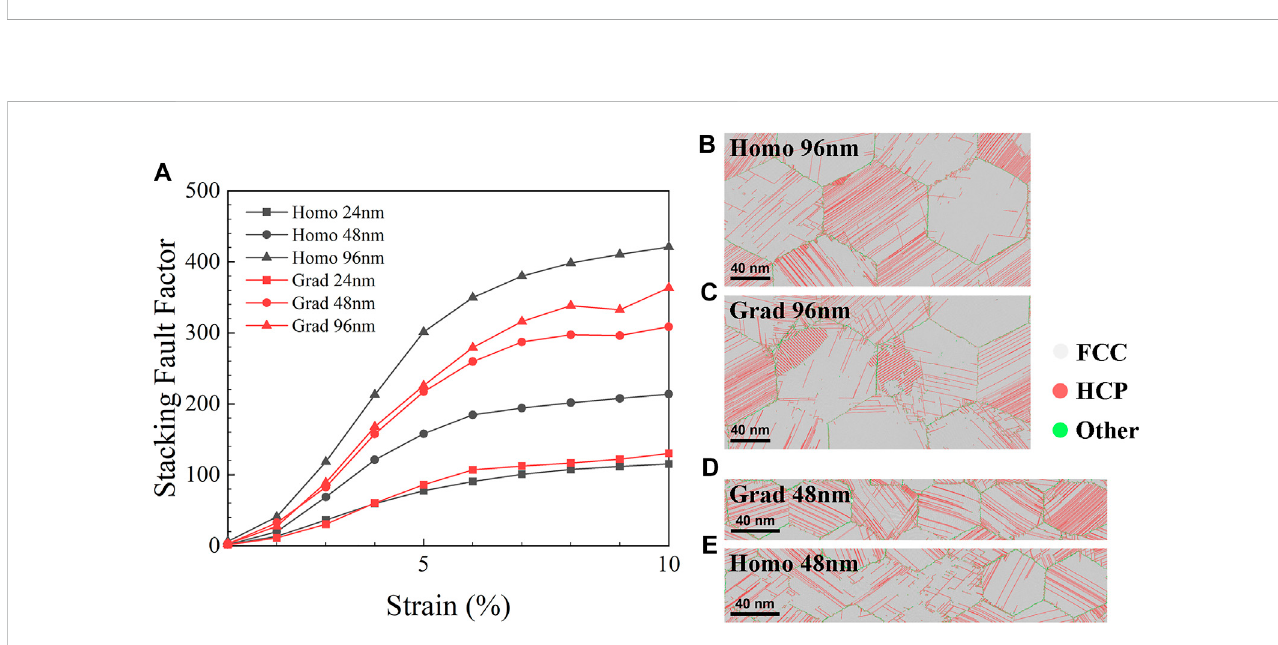
FIGURE 6 (A) Comparison ofstackingfaultfactorfromGNGstructureandhomogeneousNGstructureindifferentsizedgrains. (B – E) Structure snapshotof96and 48 nm grains from homogeneous NG structured models and GNG structured model at applied tensile strain of